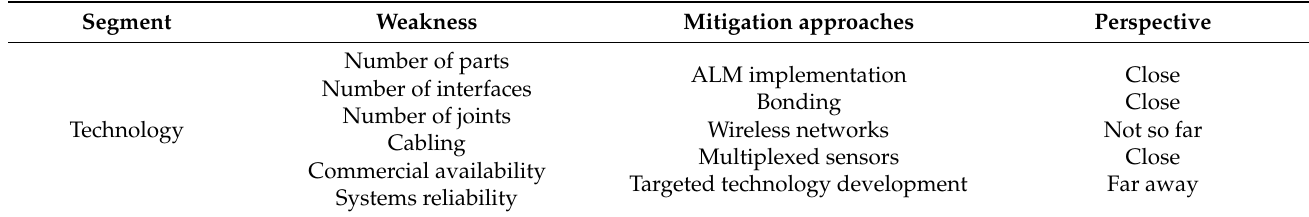
Table 5. Summary of morphing system technology